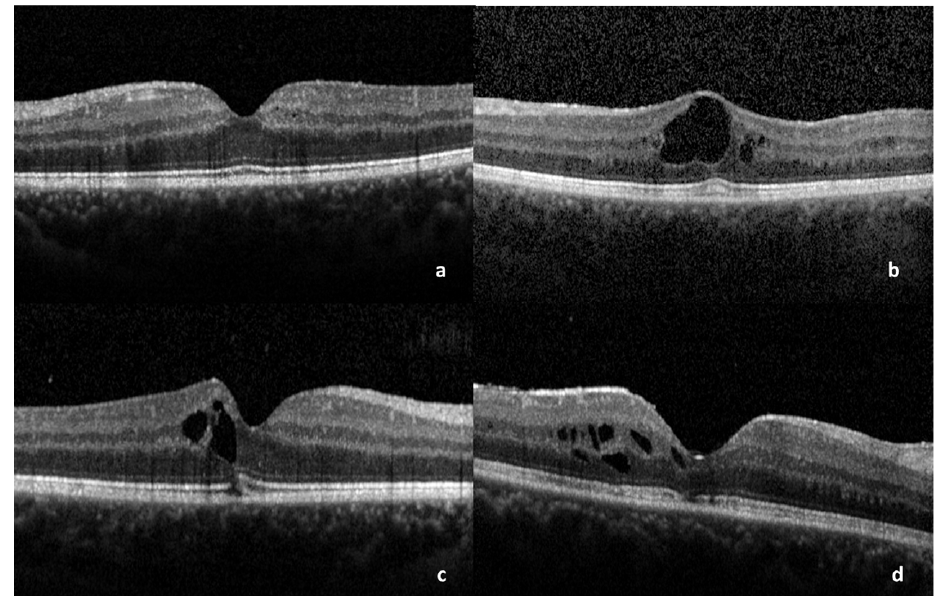
Figure 2. OCT scans showing: ( a ) ME with the maintenance of foveal bulge. ( b ) Presence of subfoveal bubble. ( c ) Disruption of COST line. ( d ) Disruption of EZ photoreceptor junction. ME: macular edema, COST: cone outer segment tip, EZ: Ellipsoid Zone.